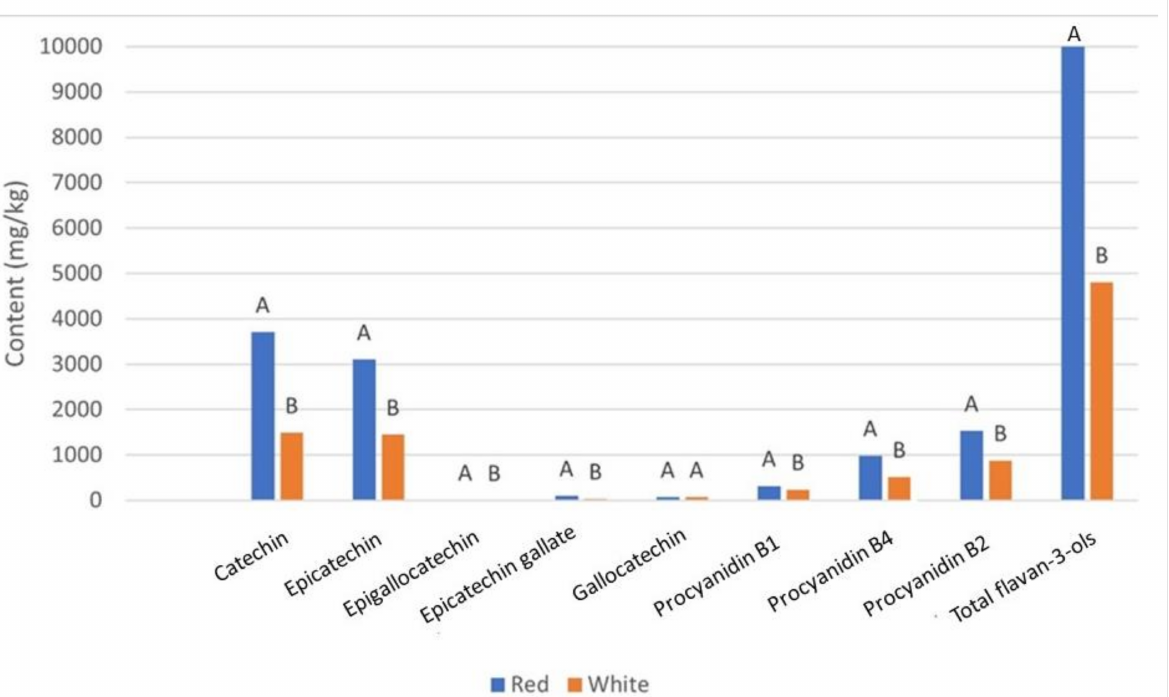
Figure 1. Mean values of total content of flavan-3-ols (mg/kg) in red and white cultivars. Different letters above individual compounds represent statistically significant difference ( p ≤